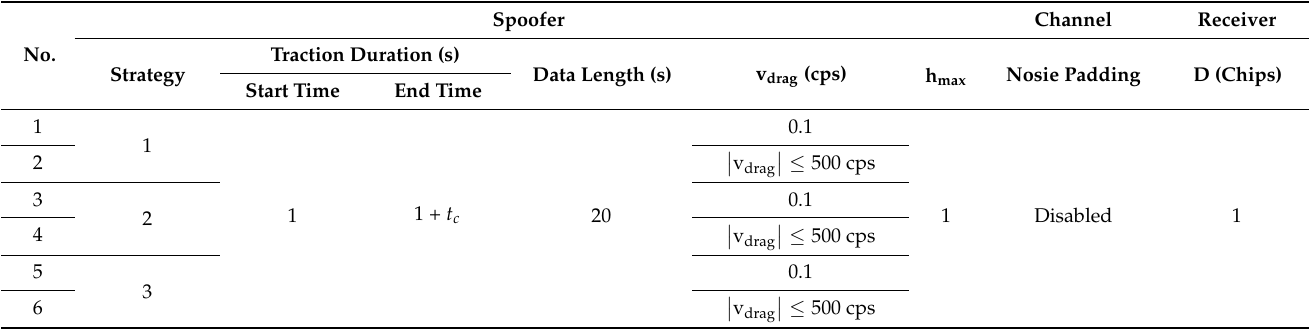
Table 1. Simulation